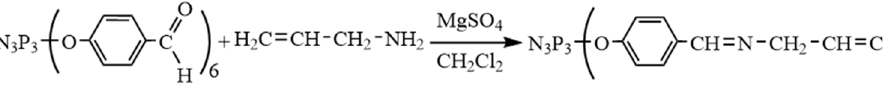
Figure 1. Synthesis of